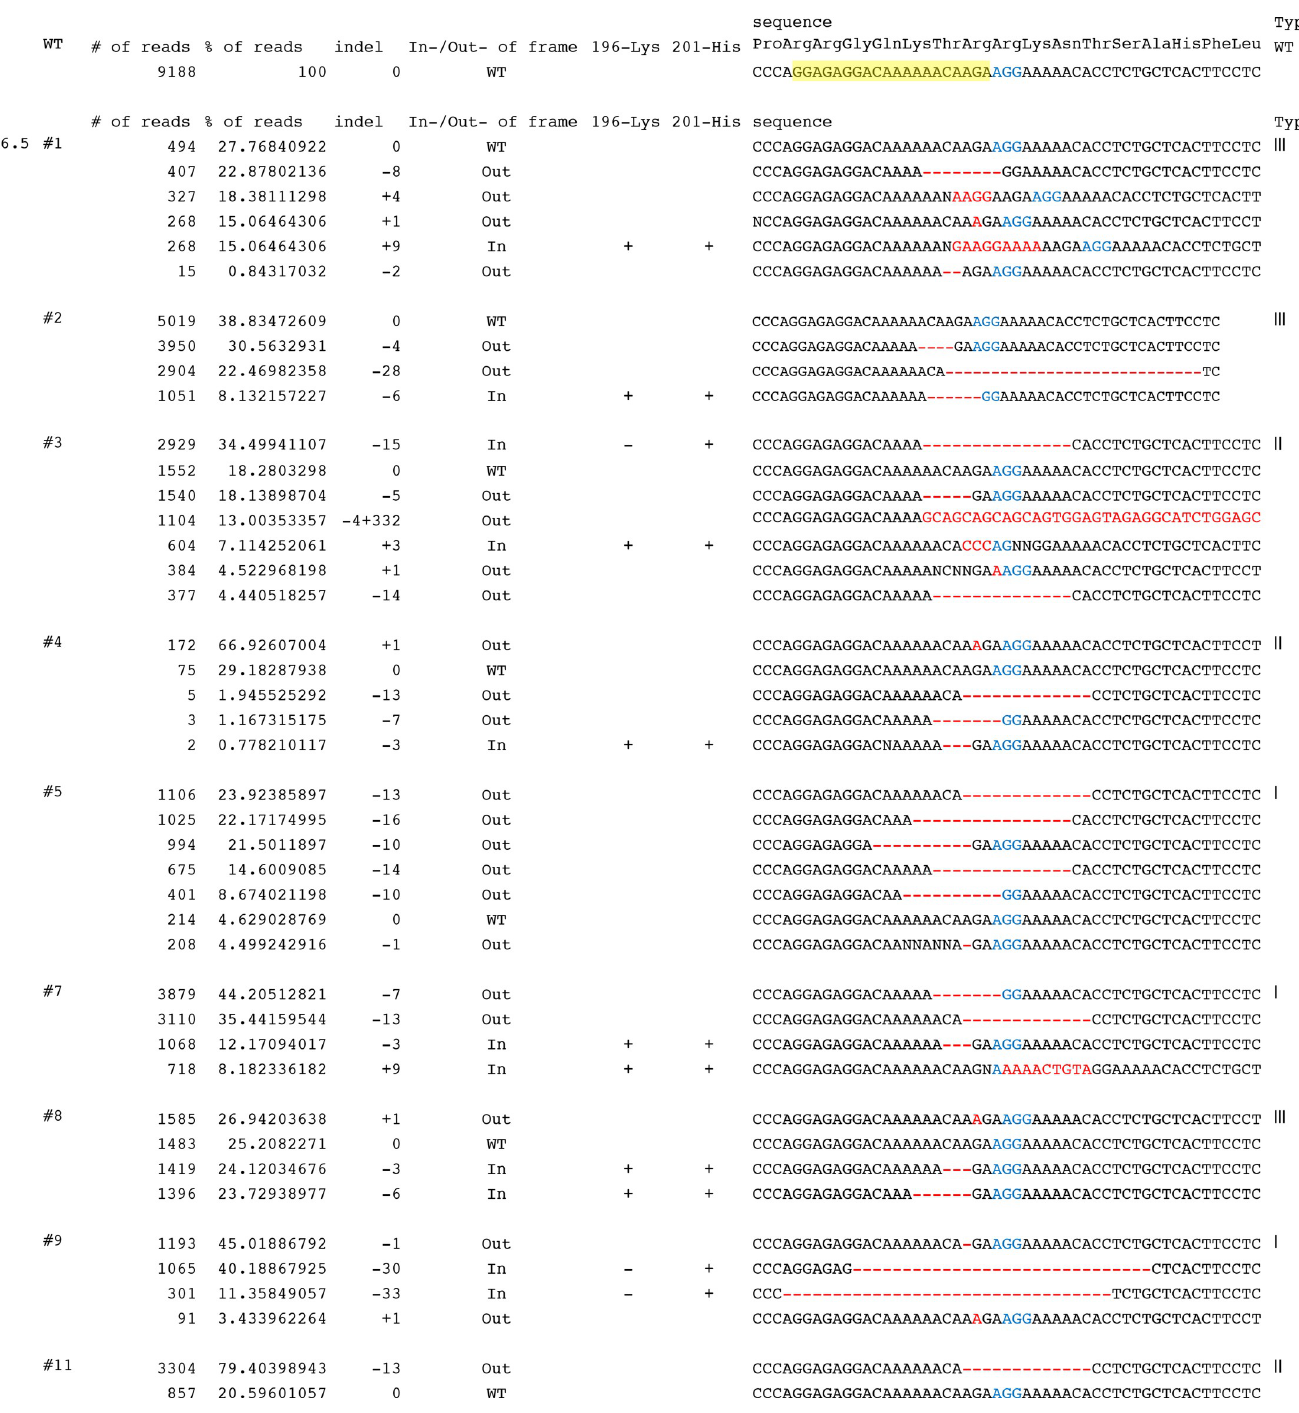
Fig 2. Genomic analysis of the Fgf10 -CRISPR F0 embryos at E16.5 as revealed by deep sequencing. The target nucleotide sequence is highlighted in yellow. Proto- spacer adjacent motif sequence is shown in blue. Insertion and deletion sequences are shown in red.